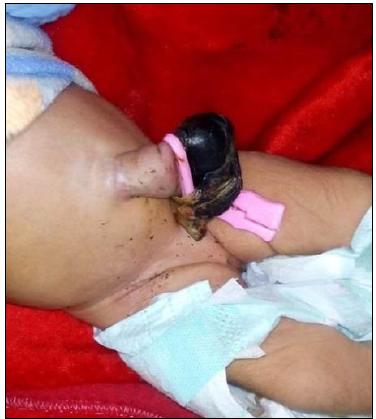
Figure 7: Accidental application of clamp over the HUC.